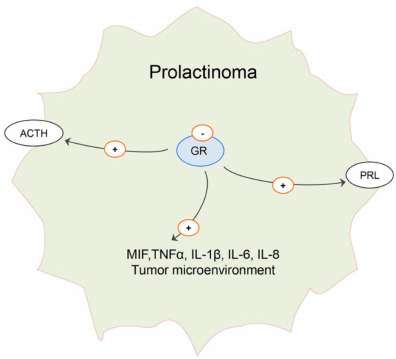
Figure 5. Hypothetic role of attenuated glucocorticoid hormone signaling in prolactinoma. Expression of glucocorticoid receptor (GR) is decreased in estrogen-induced prolactinoma and may contribute to increased adrenocorticotropic hormone (ACTH) and prolactin (PRL) secretion, as well as to changes in local secretion of growth factors and interleukins such as mitogen inhibiting factor (MIF), tumor necrosis factor α (TNF α ), interleukins (IL) 1 β , 6 and 8, thus promoting “tumor-friendly“ microenvironment